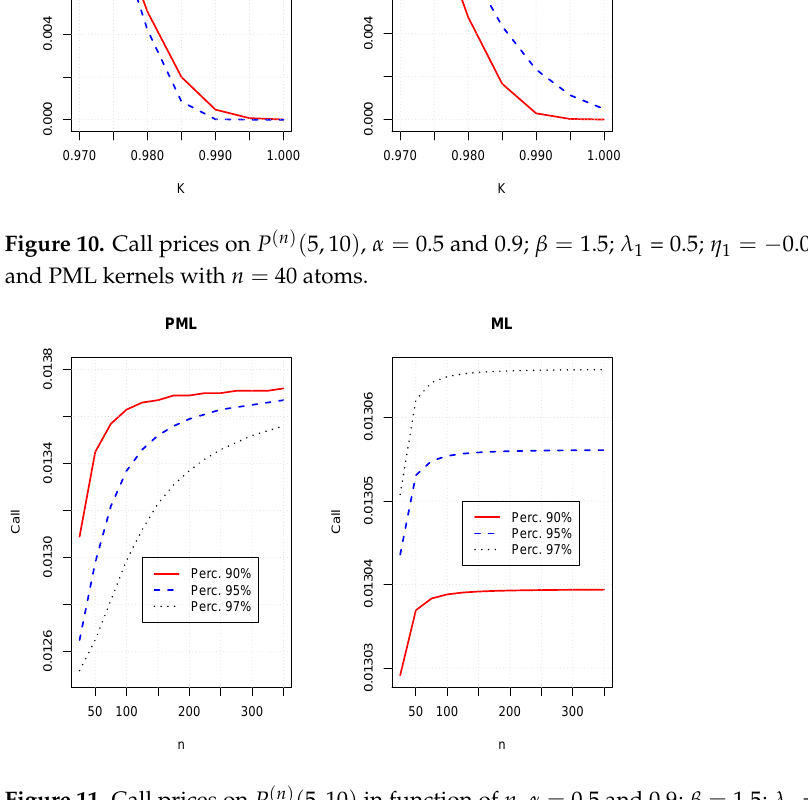
Figure 11. Call prices on P ( n ) ( 5,10 ) in function of n , α = 0.5 and 0.9; β = 1.5; λ 1 = 0.5; η 1 = − 0.002; σ 1 = 0.01. Strike =